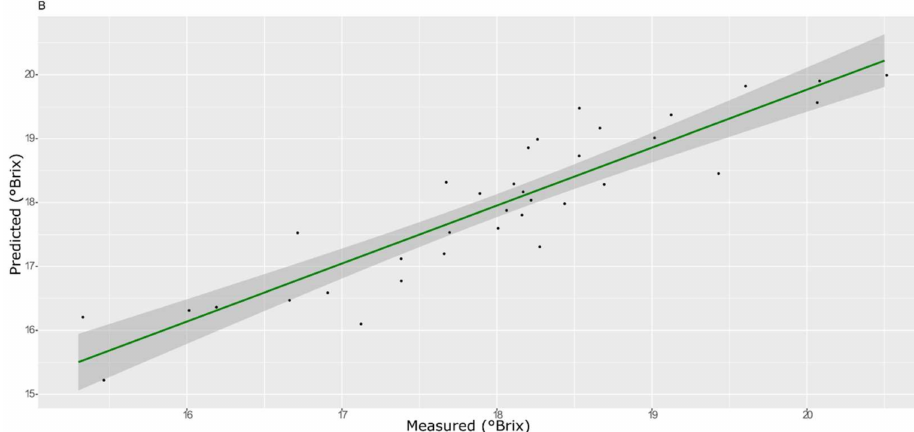
Figure 4. ANN model for TSS on the test set.